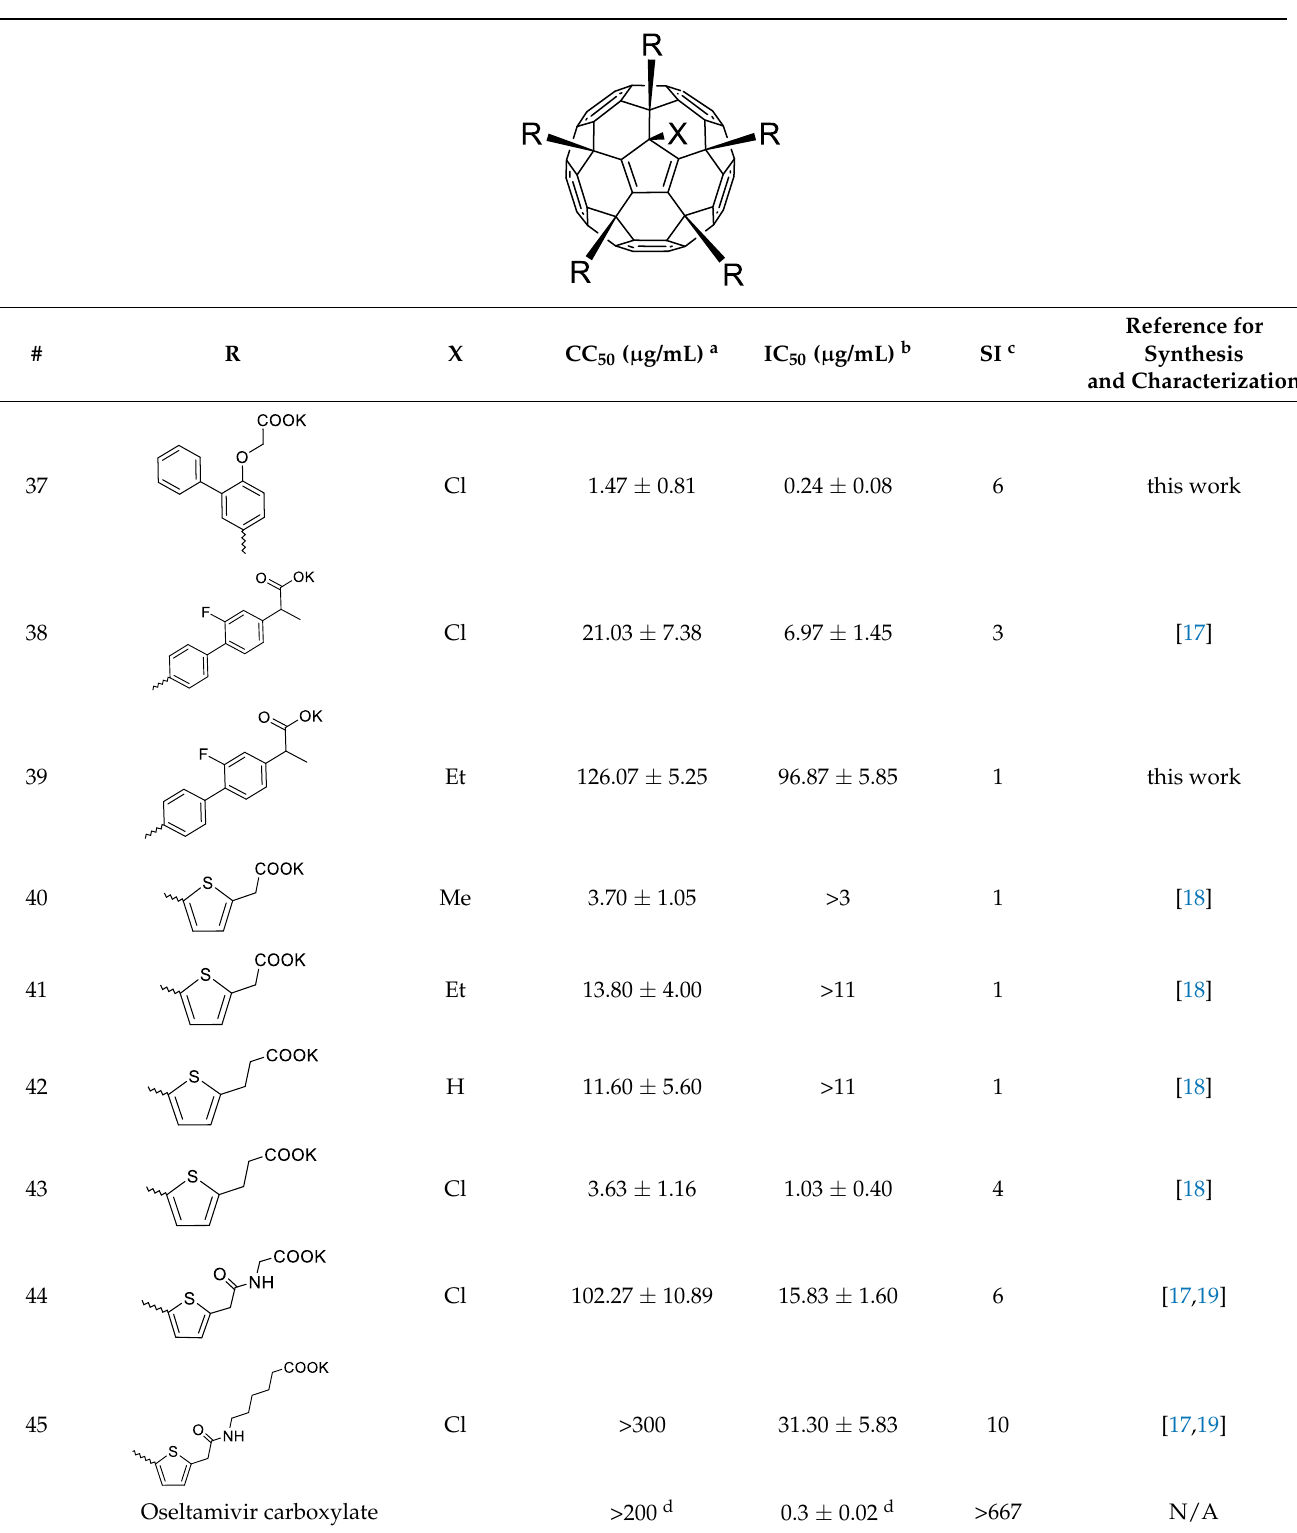
Table 1. Antiviral activity of the water- soluble fullerene derivatives against Influenza А/Puerto Table 1. Cont. Rico/8/34 (H1N1) virus in MDCK